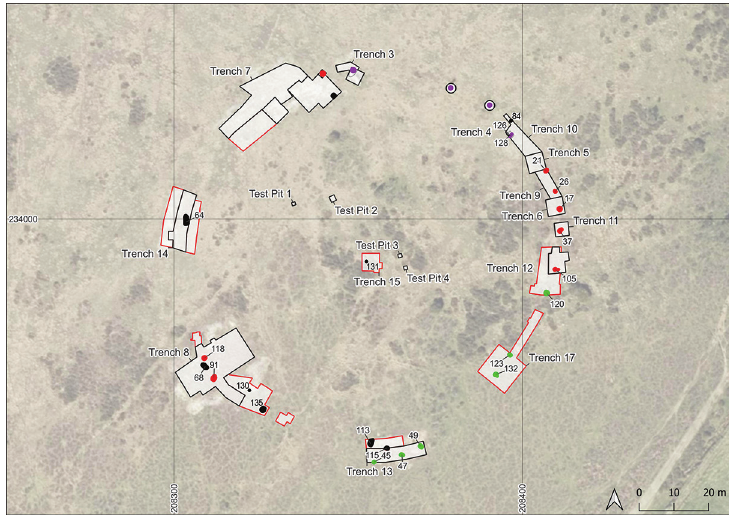
Figure 4 The excavation trenches (in black [2018] and red [2021]) at Waun Mawn, showing the locations of the four remaining standing stones (in purple), the additional stoneholes (in red), pits that never held stones (in green) and other features (in black). From the centre of the circle, the midsummer solstice sun rose within the entrance formed by Stoneholes 128 and 21 (Source: Chris Casswell and Kate